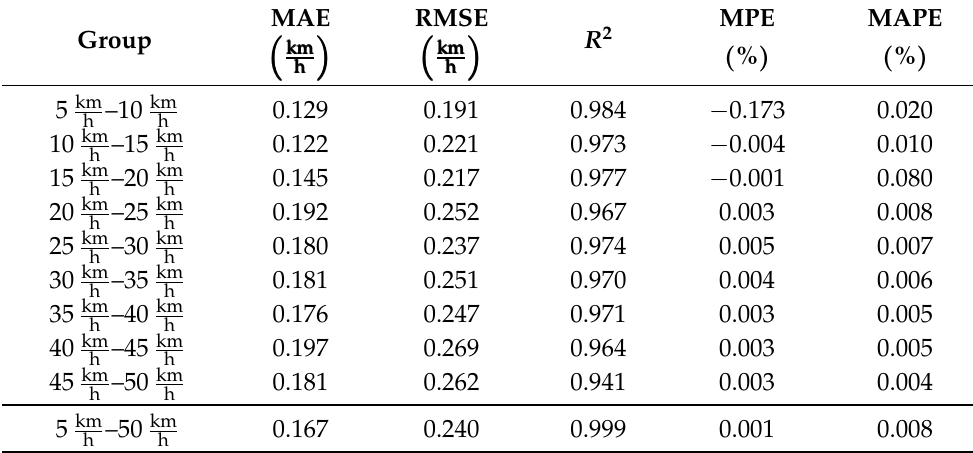
Table 2. Evaluation metrics for the baseline model for each of the velocity ranges.